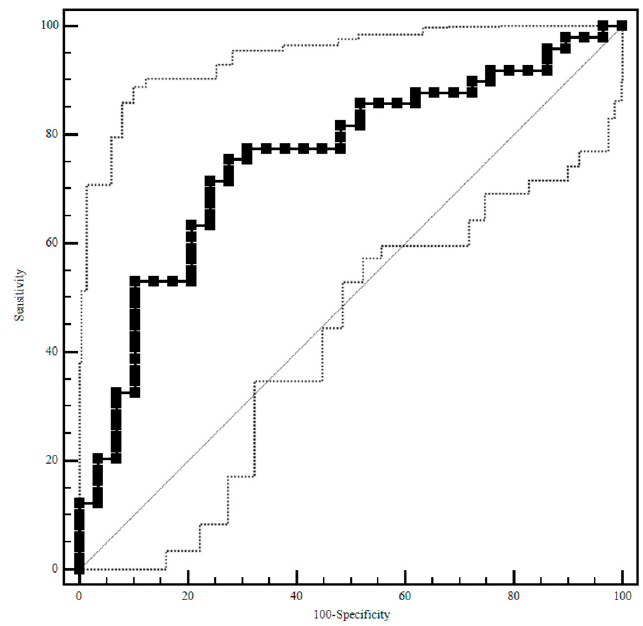
Figure 1. Salivary phosphorus ROC curve analysis.